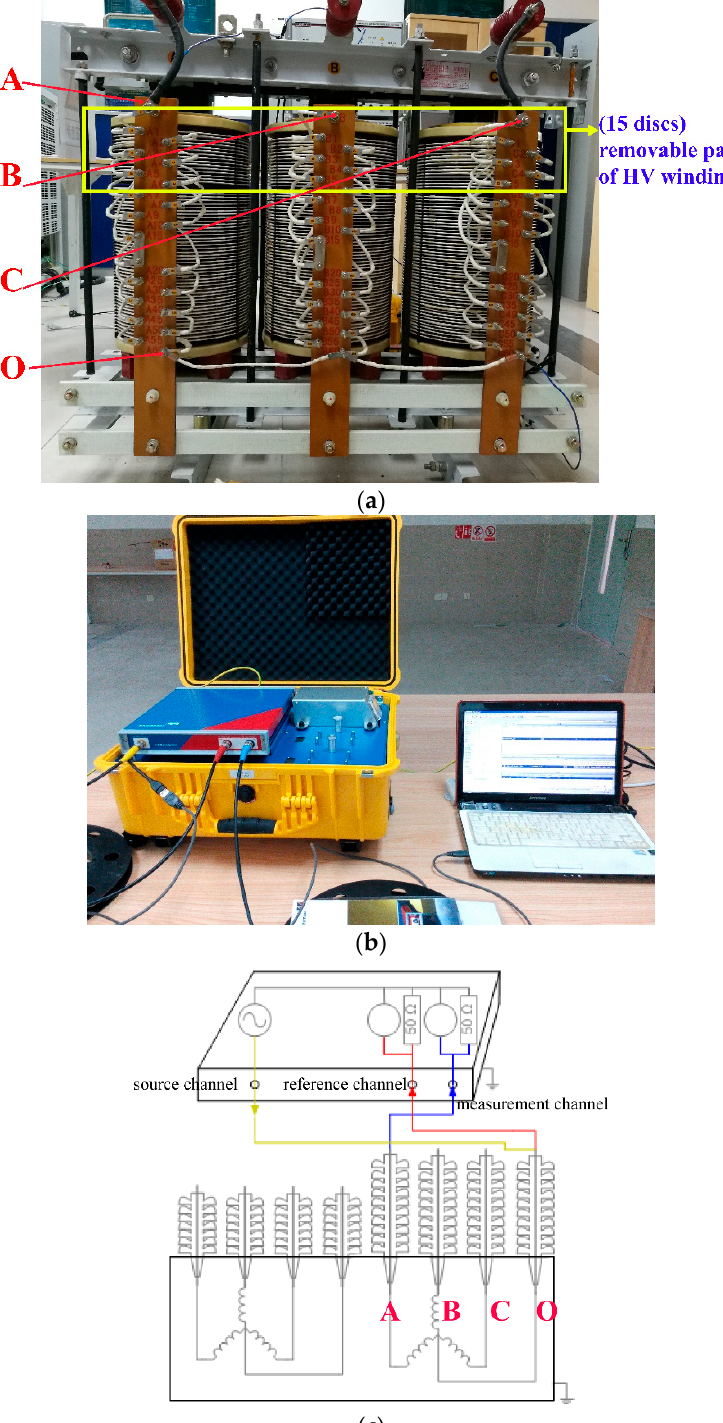
Figure 5. Experimental setup for experimental simulation of mechanical deformation (MD): ( a ) the custom-made test object; ( b ) measurement device, sweep frequency response analyzer; and ( c ) schematic diagram of the connection method.